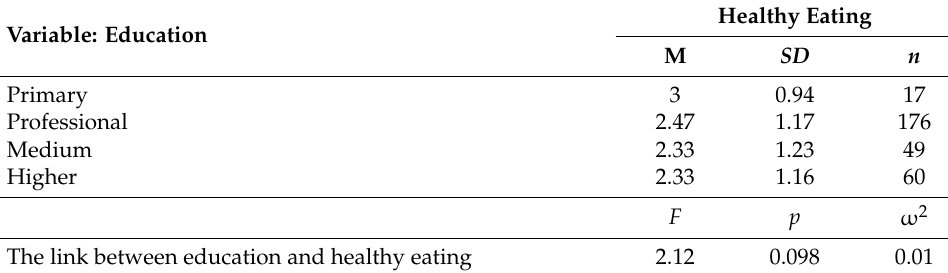
The relationship between healthy eating and where you live Table 5. Relationship of healthy eating with education.